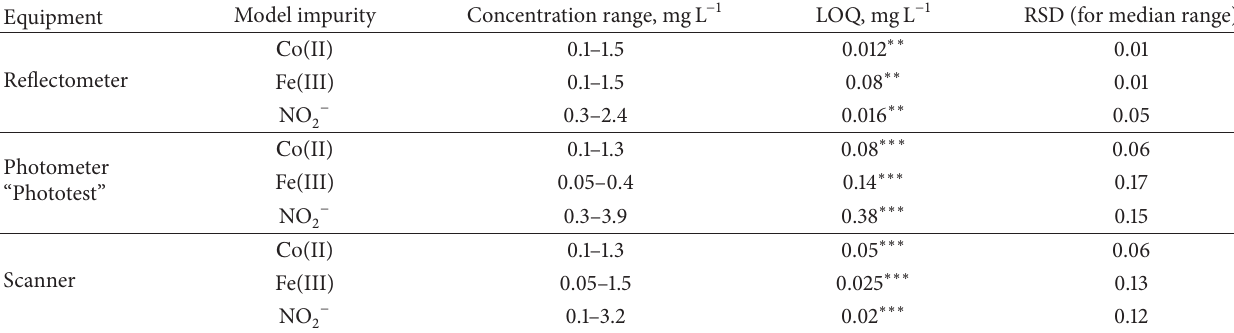
Table 1: The comparison of test results using various portable equipment ∗ .